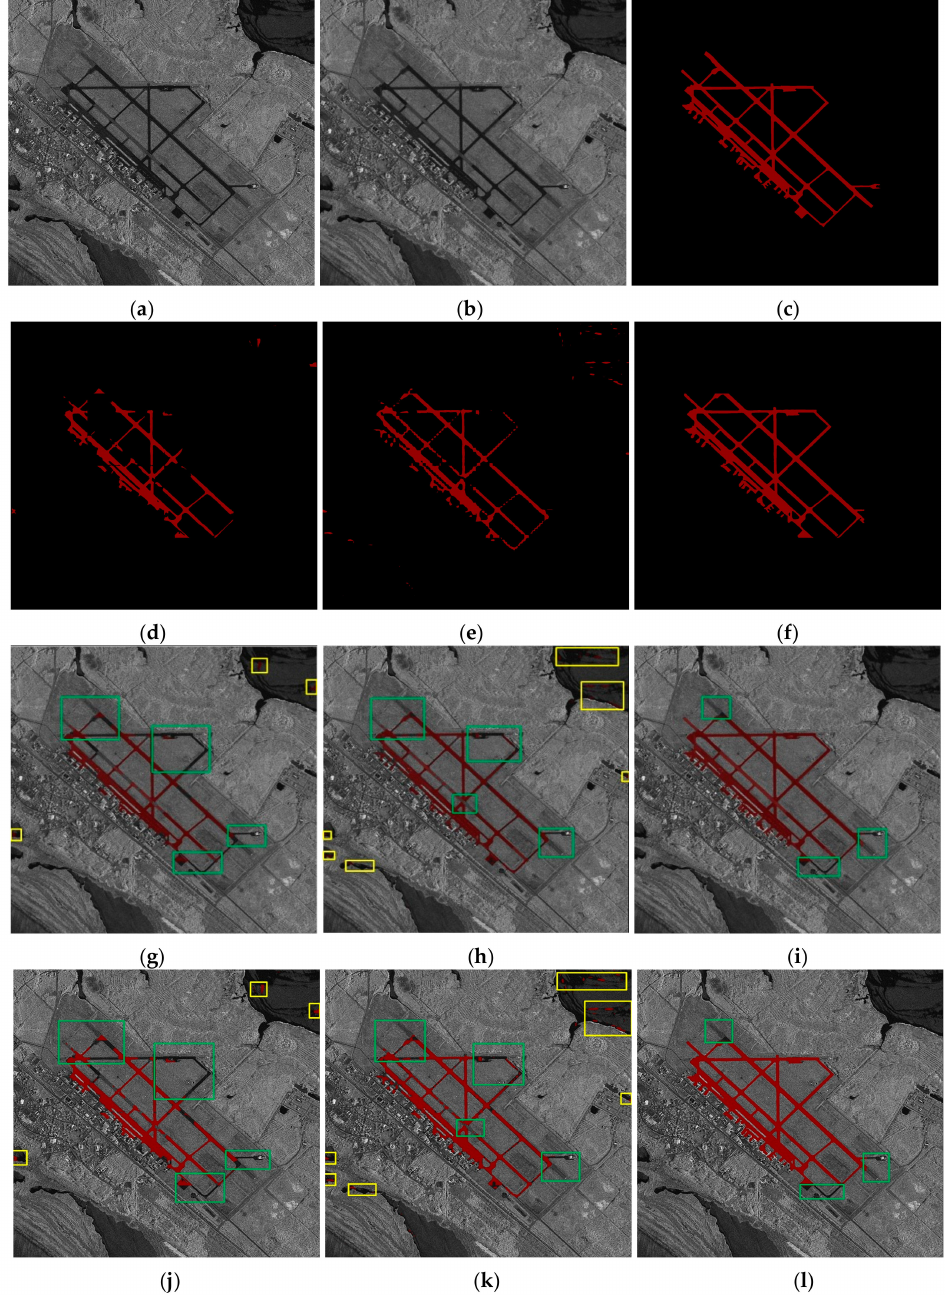
Figure 11. The experiment result for Airport III. ( a ) SAR image of Airport III from Gaofen-3. ( b ) The down-sampled SAR image of ( a ) by 5 times. ( c ) The ground truth of the airport for ( b ). ( d ) The extraction result of ( b ) by RefineNet. ( e ) The extraction result of ( b ) by DeepLabV3. ( f ) The extraction result of ( b ) by MDDA. ( g ) The fusion map of ( d , b ). ( h ) The fusion map of ( e , b ). ( i ) The fusion map of ( f , b ). ( j ) The fusion map of ( a , d ) up-sampled by 5 times. ( k ) The fusion map of ( a , e ) up-sampled by 5 times. ( l ) The fusion map of ( a , f ) up-sampled by 5